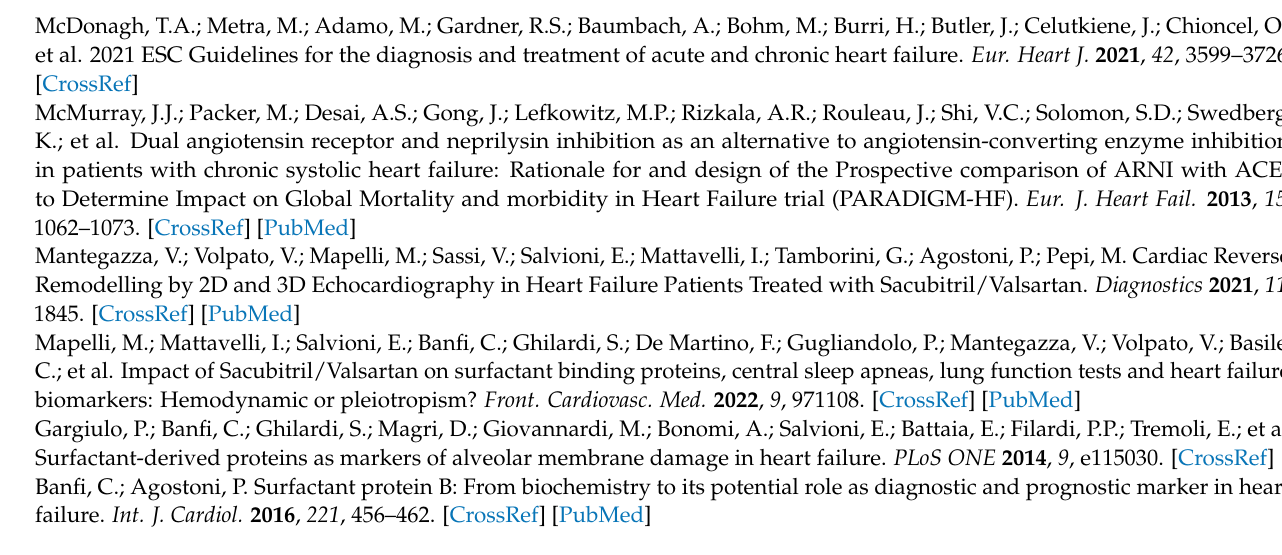
Table S1: Characteristics of the study population after 6 months of treatment at the maximum dose of Sacubritil/Valsartan; Table S2: Characteristics of the healthy subjects enrolled at CCM; Table S3: List of miRNA modulated by treatment or by disease obtained from the miRNA screening; Table S4: Spearman’s correlation between variation of miRNAs and clinical parameters between follow-up and baseline; Table S5: miRNA targets identified using Mienturnet